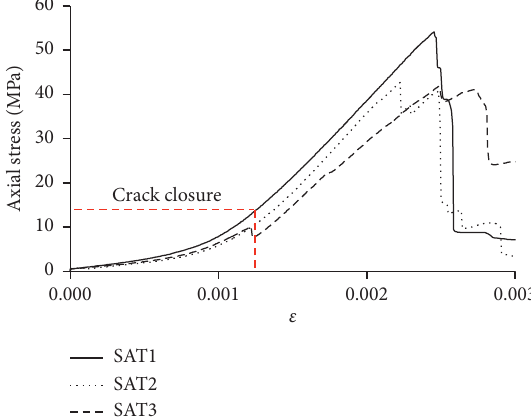
Figure 6: Tuff stress-strain curves under saturated condition obtained from uniaxial compression